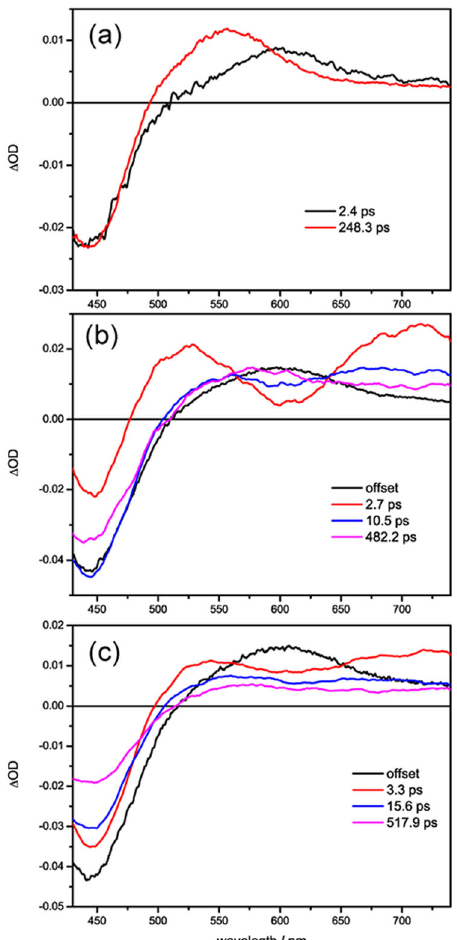
Fig. 6 The ultrafast transient absorption data quantitatively analyzed by a global fi t. Evolution-associated difference spectra (EADS) of the corresponding kinetics components obtained from global analysis of the ultrafast transient absorption spectra for [Ru(phen) 2 dppz] 2 + in water ( a ), HT G-quadruplex ( b ), and Oxyticha nova G-quadruplex ( c